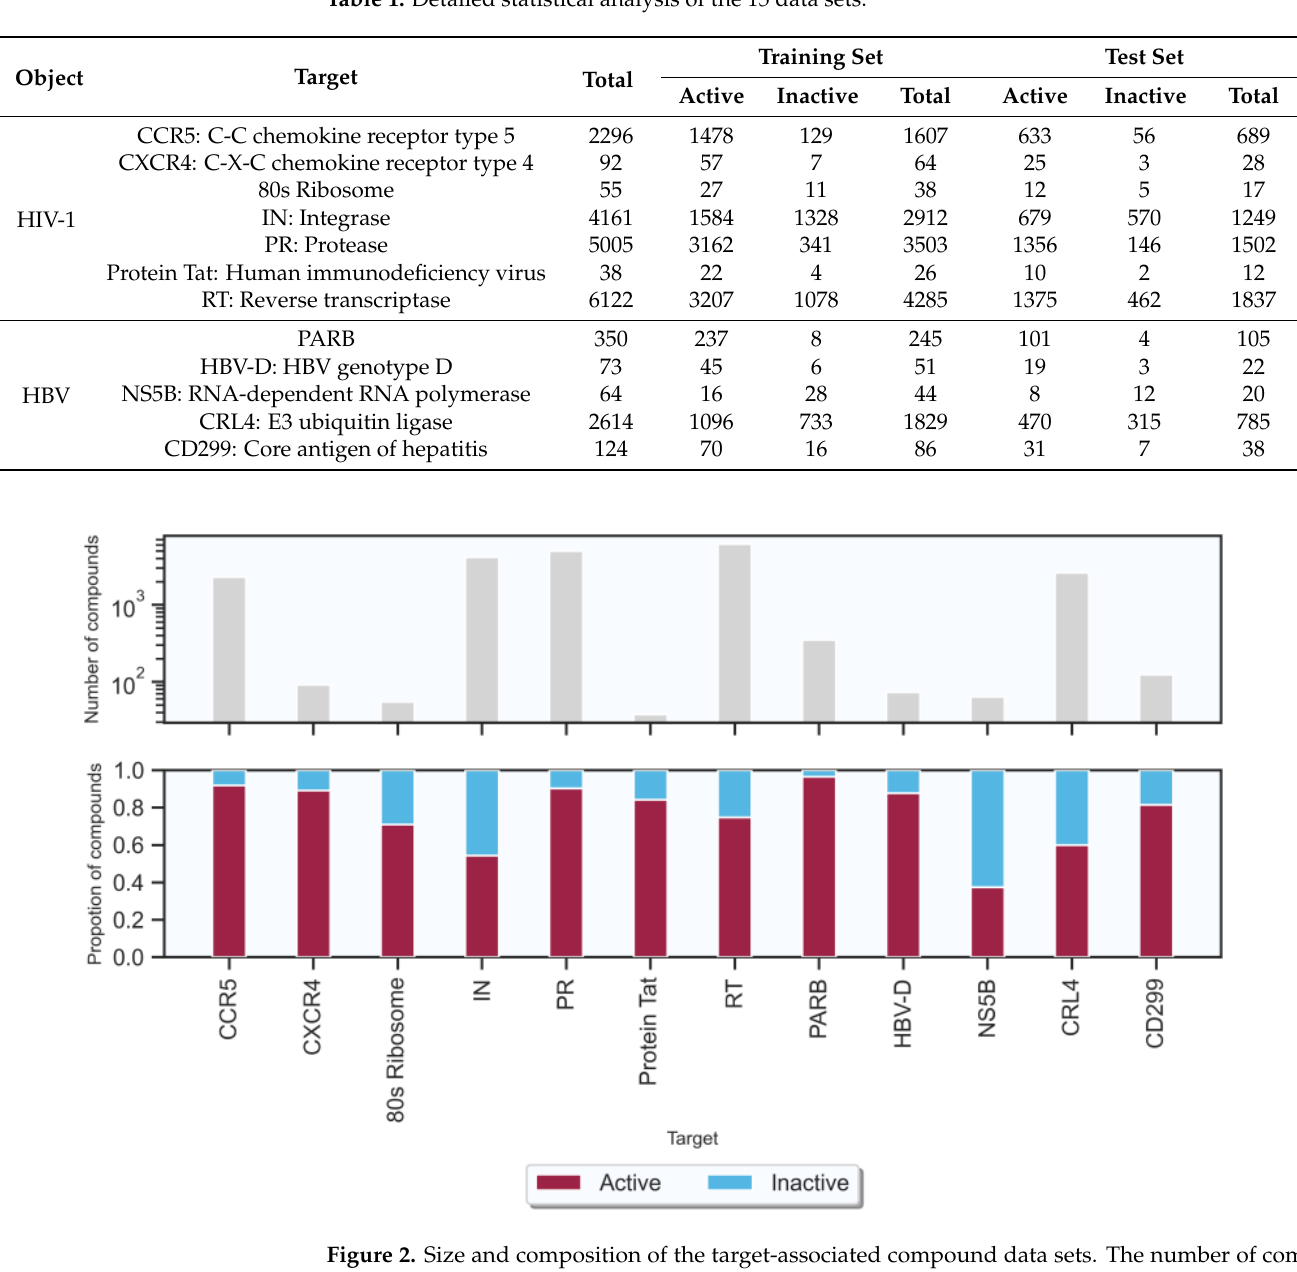
Table 1. Detailed statistical analysis of the 15 data sets.